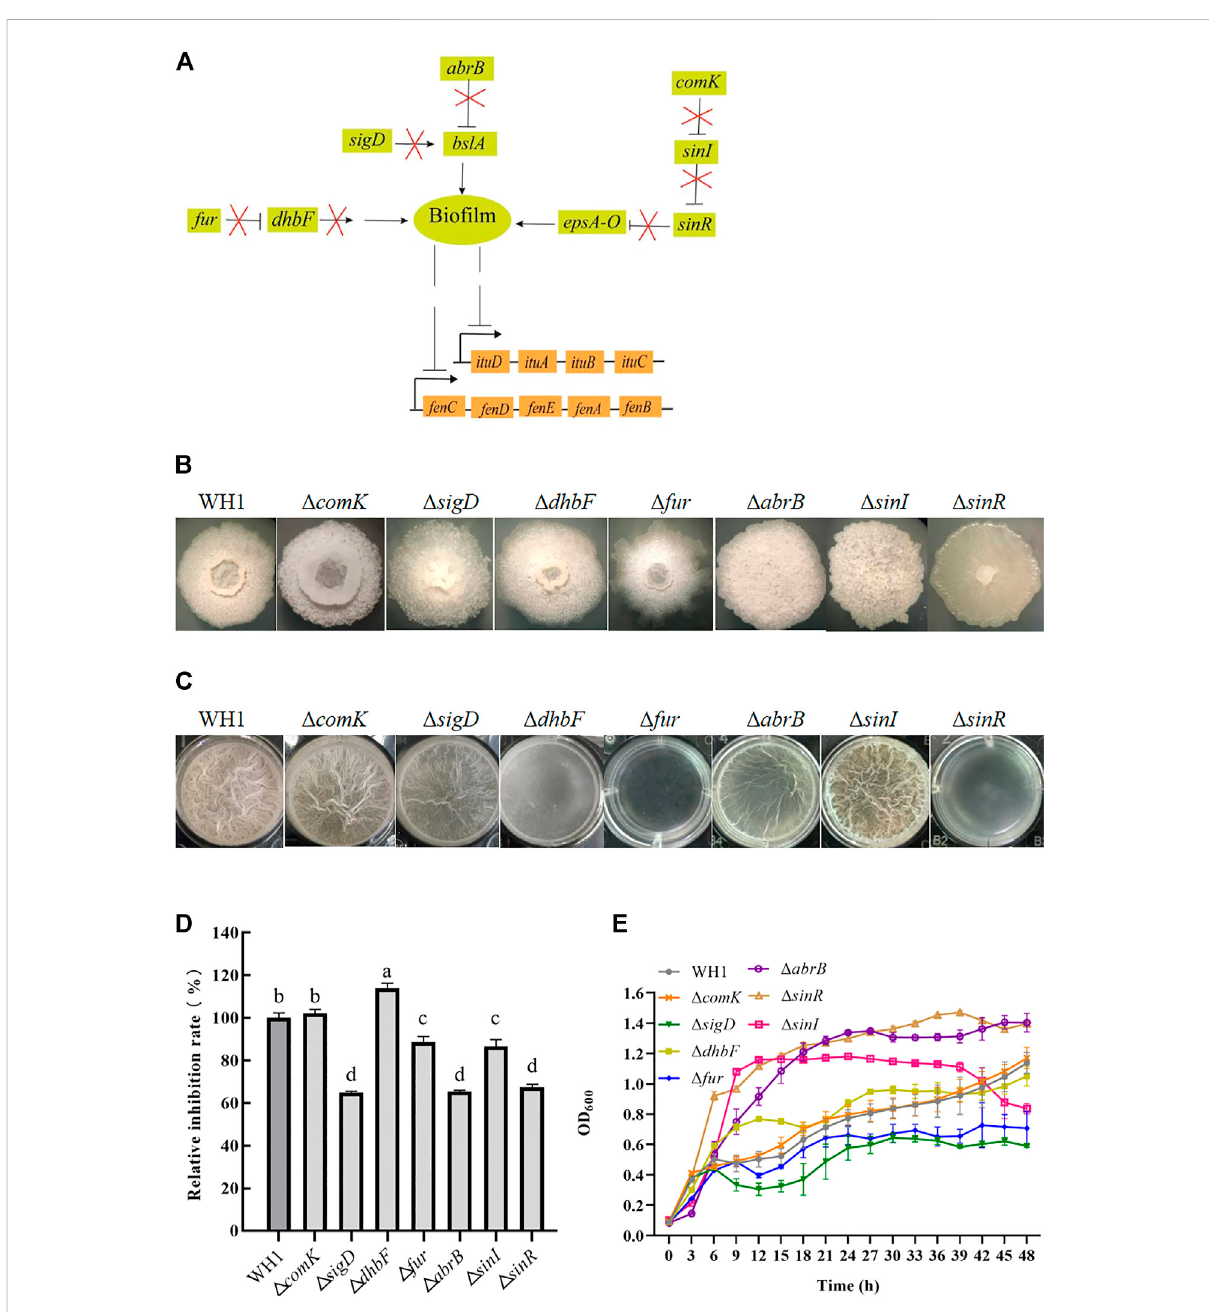
FIGURE 5 Relative inhibition rates and characteristics of knockout strains related with bio fi lm formation. (A) : Regulation of bio fi lm formation. The bslA gene encodes an extracellular protein of bio fi lm; the epsA - O operon encodes the enzymes for biosynthesizing exopolysaccharides of bio fi lm. ComK: competence transcription factor; SigD: sigma factor D; DhbF: enzyme for biosynthesis of siderophore; Fur: repressor of dhb ; AbrB and SinR: regulators to suppress bio fi lm formation; SinI: regulator to promote bio fi lm formation. (B) : Colony morphology. (C) : Bio fi lms. (D) : Relative inhibition rates. (E) : Growth